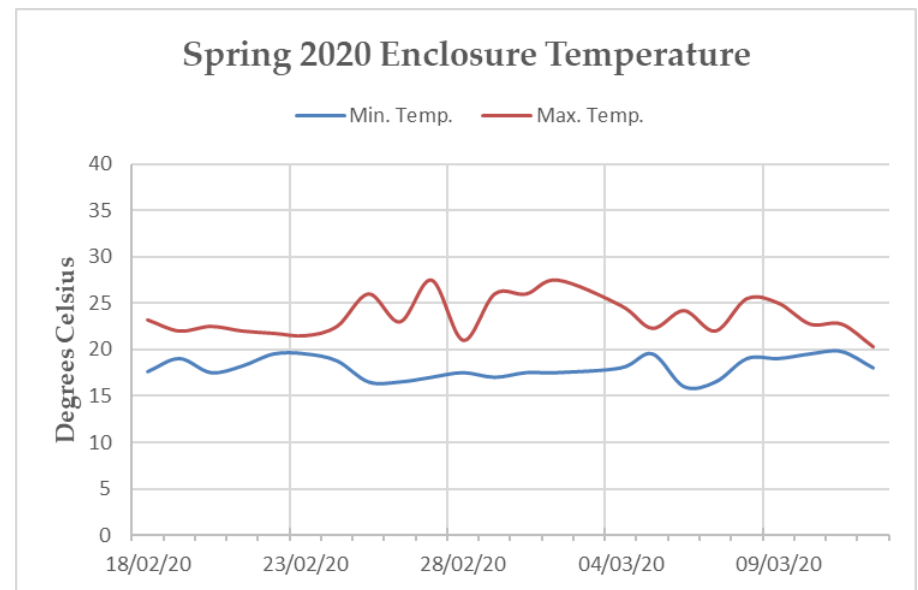
Figure A3: Line graph of the minimum and maximum average temperatures reported by the internal temperature monitoring system of the “Island Bat Roost” at Jersey Zoo between February and March of 2020. Dates listed are five days apart. Tick marks along the x-axis denote one day.